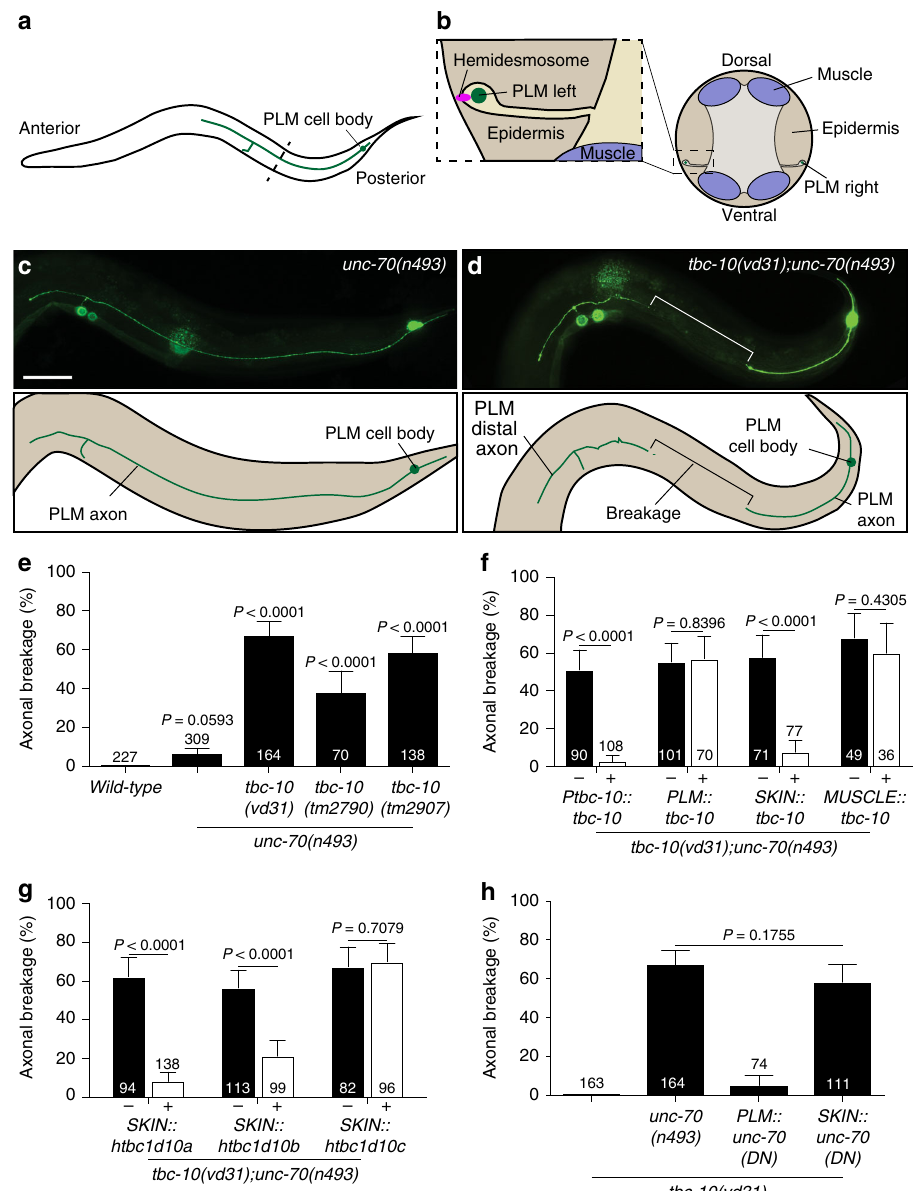
Fig. 1 TBC-10 and UNC-70/ β -spectrin function in the epidermis to protect against axonal breakage. a Scheme showing the location and morphology of the PLM touch receptor neuron. b A schematic transverse section through the animal (dotted line in a ) illustrating the region in which the PLM axon is ensheathed in the epidermis and attached via hemidesmosomes. c An image and scheme showing a typical unbroken axon of the PLM neuron in unc-70 (n493) mutants visualized with GFP (transgene zdIs5(Pmec-4::GFP)) . d An image and scheme showing a typical broken axon of the PLM neuron in tbc-10 (vd31);unc-70(n493) animals. e Mean penetrance of axonal breakage in wild-type, unc-70(n493) mutants, and multiple alleles of tbc-10 in an unc-70 background. f Mean penetrance of axonal breakage in tbc-10;unc-70 mutants carrying transgenes expressing wild-type tbc-10 under either an endogenous promoter, a touch receptor neuron-promoter, an epidermal-speci fi c promoter, or a muscle-speci fi c promoter, versus their respective non-transgenic siblings. g Mean penetrance of axonal breakage in tbc-10(vd31);unc-70(n493) mutants carrying transgenes expressing the wild-type human orthologs tbc1d10a-c under an epidermal-speci fi c promoter versus non-transgenic siblings. h Mean penetrance of axonal breaks in tbc-10 single and tbc-10(vd31);unc- 70(n493) double mutants, versus tbc-10(vd31) mutants expressing single-copy insertions of the semi-dominant UNC-70(DN)::mKate2 driven by touch receptor neuron or epidermal-speci fi c promoters. Scale bar in c = 50 μ m. P -values in e and h are determined from a one-way ANOVA with a Tukey multiple-comparison of proportions using an Agresti – Coull interval. P -values in f and g are determined from a comparison of proportions using an Agresti – Coull interval. Error bars indicate a 95% con fi dence interval. N -values are indicated on bar graphs and represent the number of individual animals scored for each condition. Source data are provided as a Source Data fi